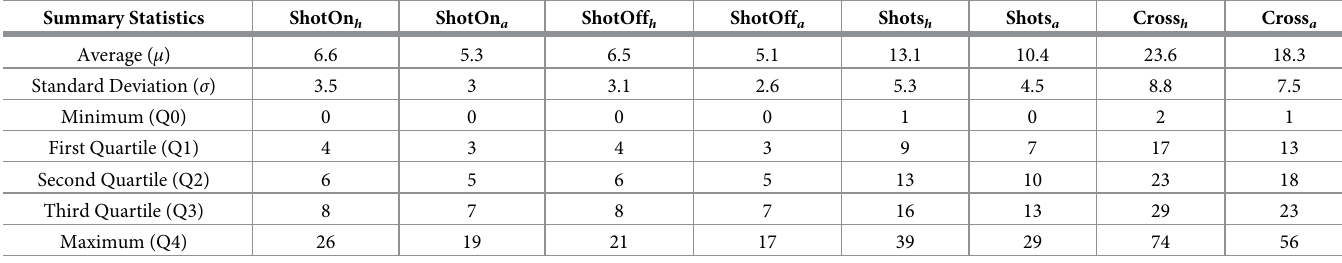
Table 3. Match statistics’ statistical summary.